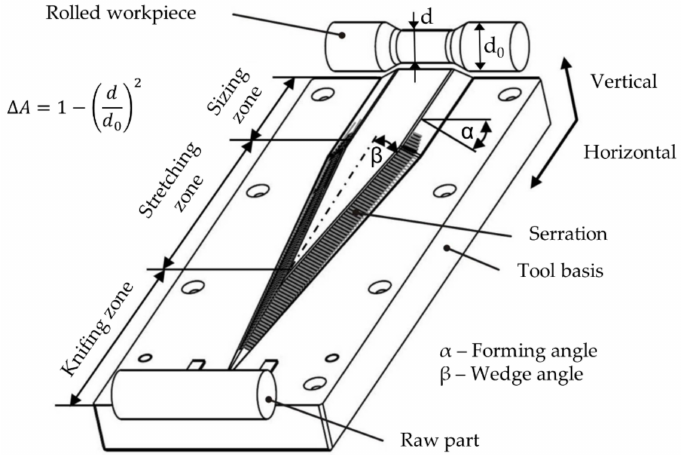
Figure 1. Principle of a cross-wedge rolling (CWR) process, including important forming